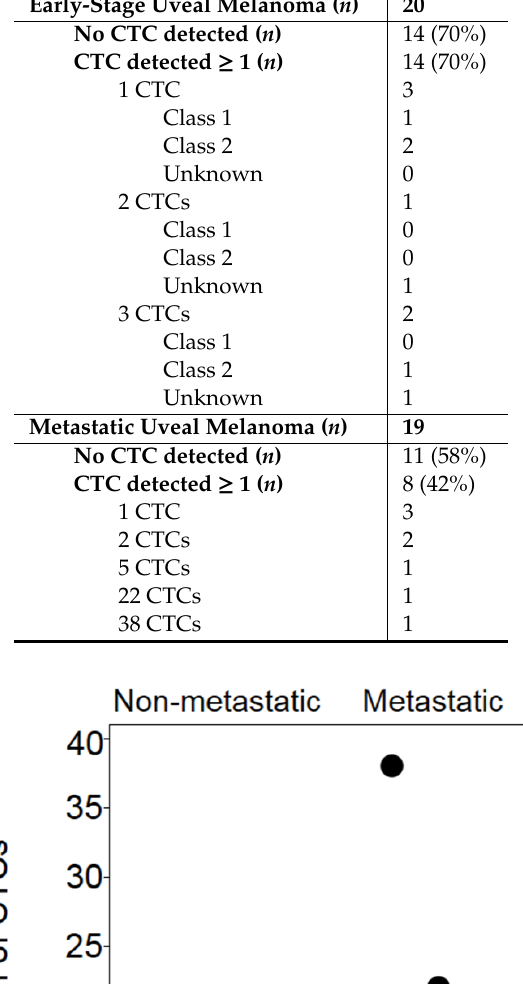
Table 2. Circulating tumor cells at initial draw